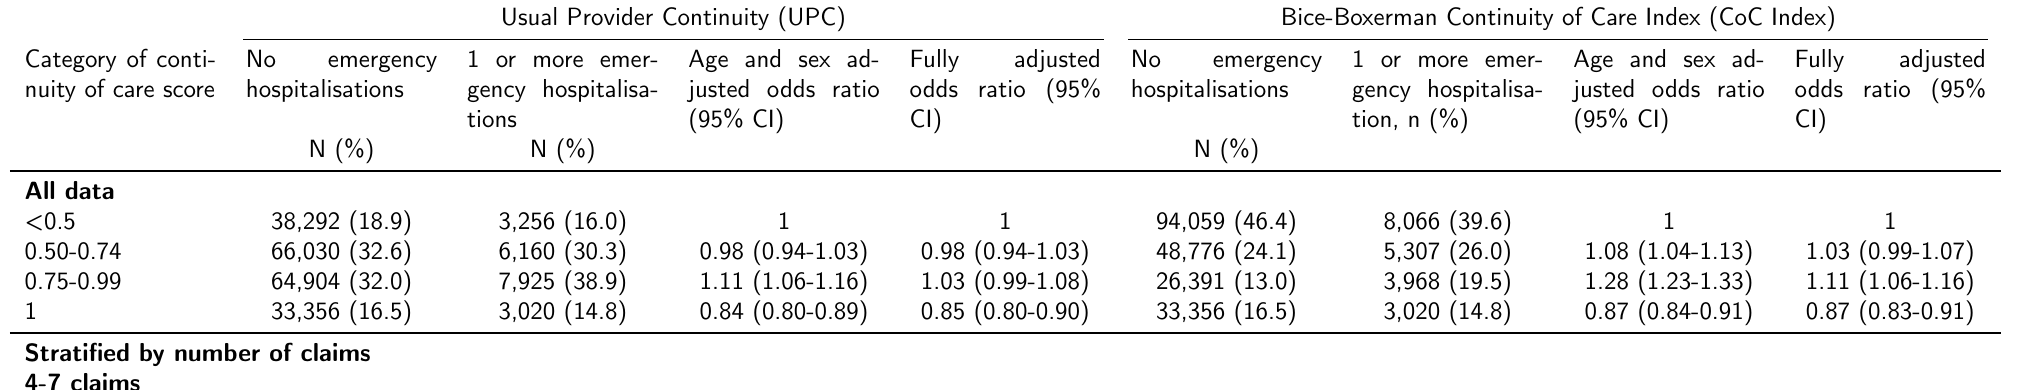
Table 1: Association between continuity of care and emergency hospitalisation Usual Provider Continuity